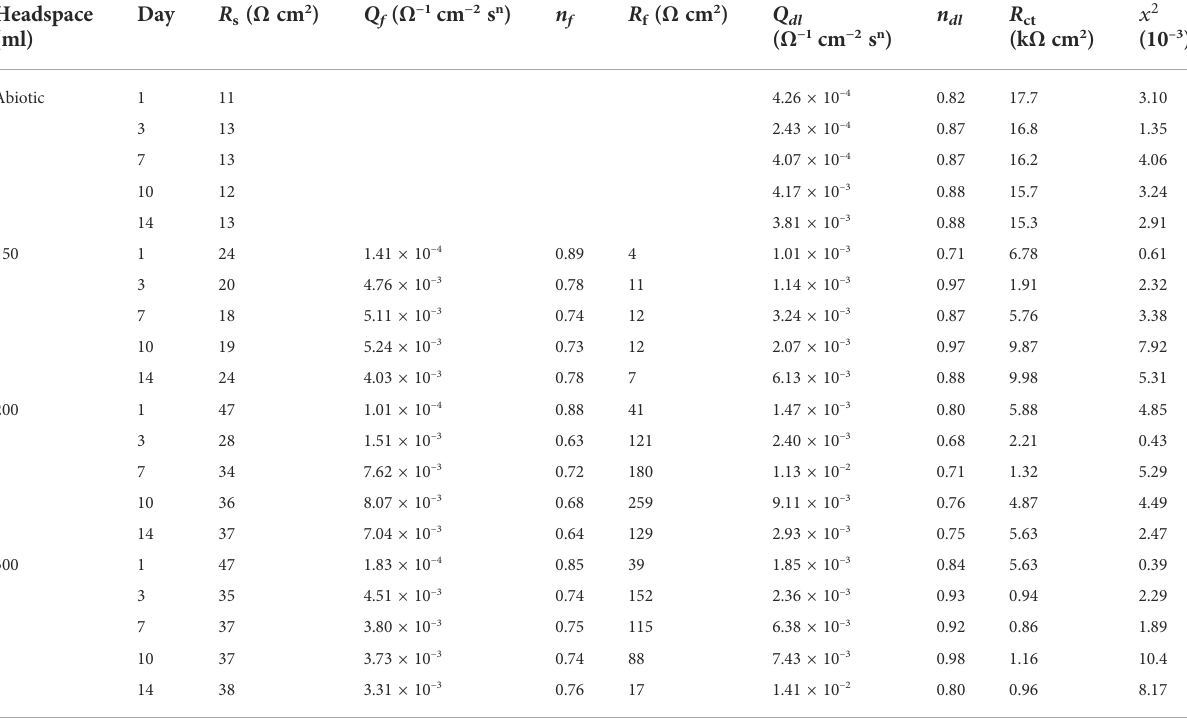
TABLE 2 Electrochemical parameters obtained from fi tting EIS spectra in Figure 5. Headspace (ml)